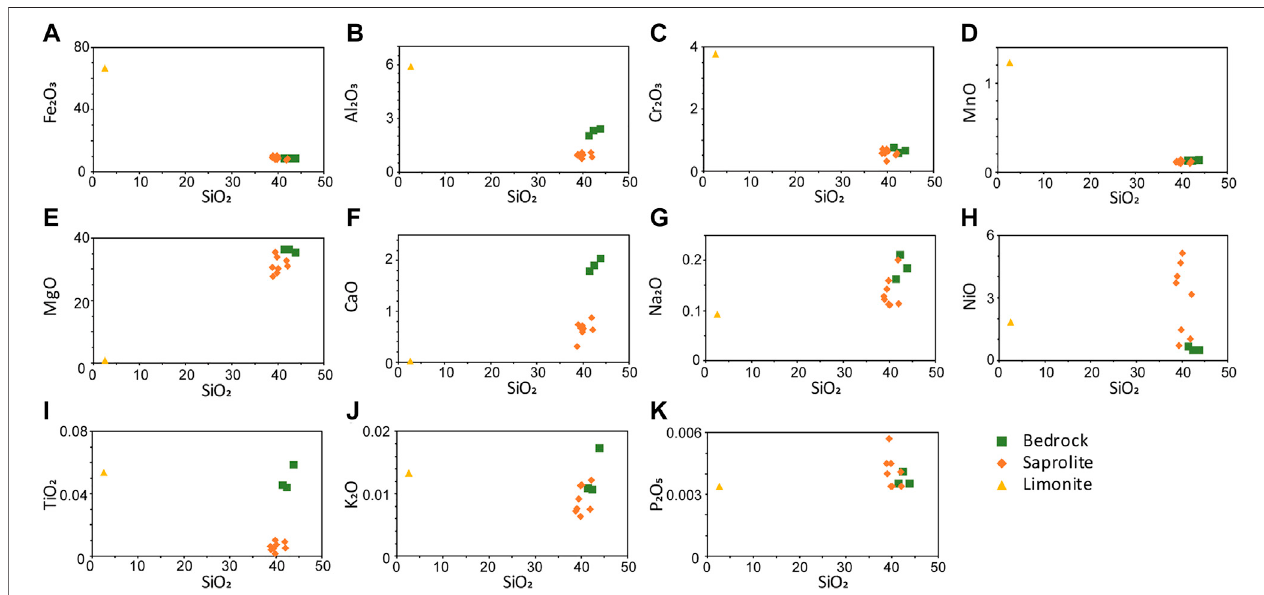
FIGURE 7 | Elemental distribution in bedrock, saprolite, and limonite horizons of the Morowali deposit. With the progress of laterization, a decrease in SiO 2 was observed.